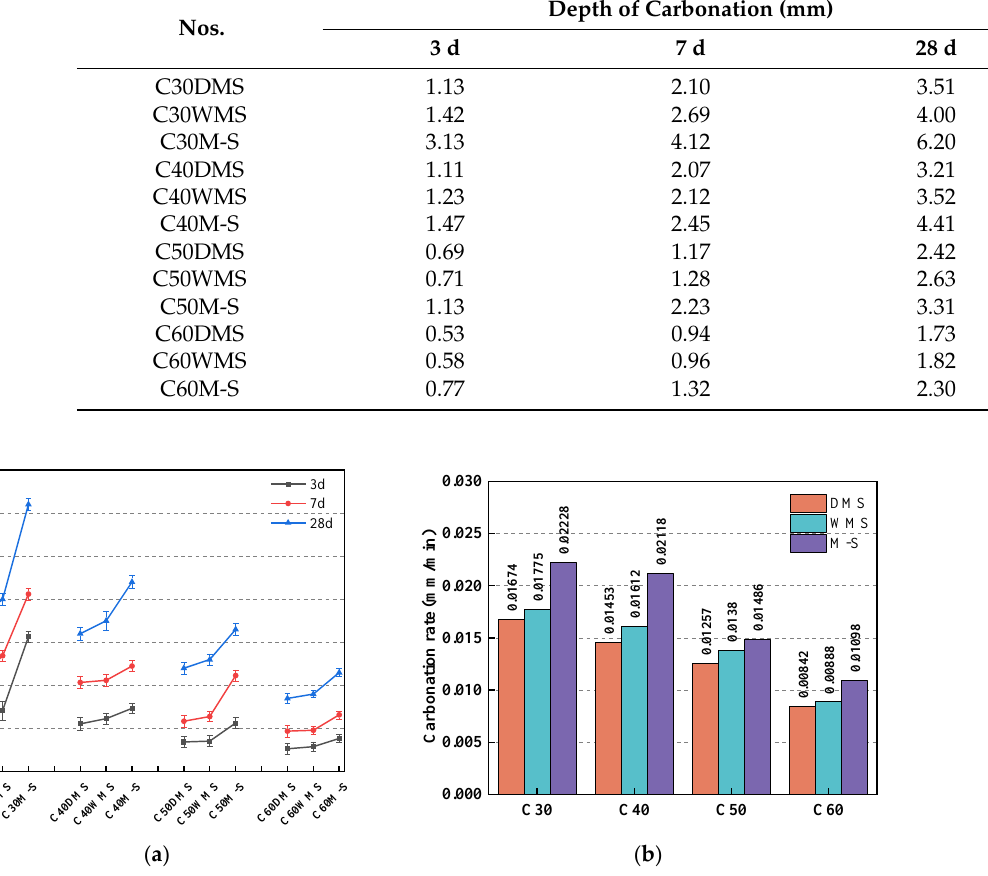
Figure 14. Carbonation resistance of each concrete group: ( a ) depth of carbonation; ( b ) carbonation rate.